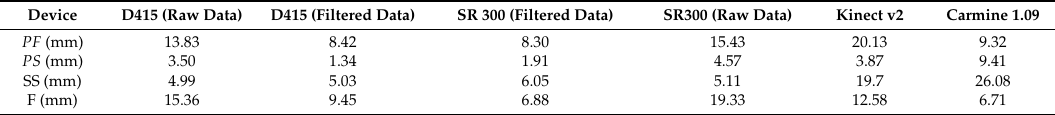
Figure 11. ( a ) The 3D recording of the single sphere captured in 10 arbitrary positions homogeneously distributed within the working volume. ( b ) 3D points of the ball-bar captured in 7 positions within the working volume (the same sphere color corresponds to the same bar). ( c ) 3D points of the plane captured in 6 positions within the working volume. Table 6. The comparison between D415, SR300, Kinect v2 and PrimeSense Carmine 1.09 in terms of VDI/VDE error